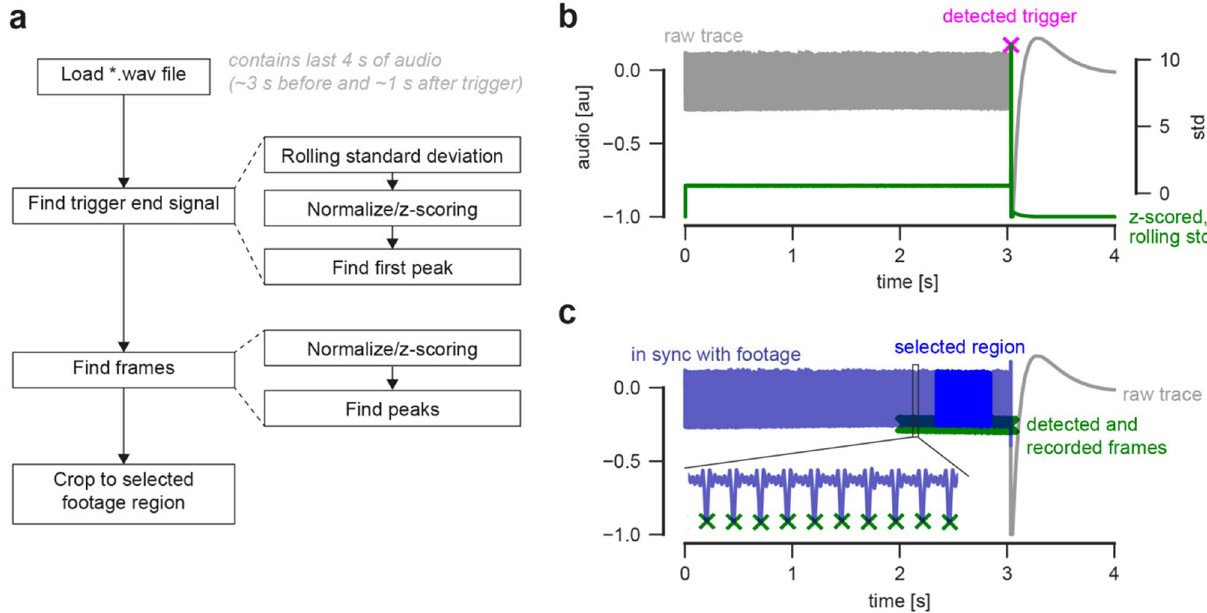
Figure 3. Audio–Video alignment. ( a ) Analysis pipeline. ( b ) Detection of end trigger using a normalized, rolling standard deviation (std) on example data. ( c ) Detection of recorded frames and extraction of selected area on the same example data as shown in panel ( b